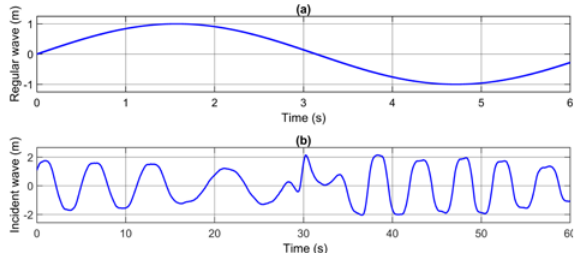
Fig. 7. Input wave data; (a) A regular wave for one wave period of 6 s in Case I; (b) The irregular waves for, Case II: 0-29 s, and Case III: 30-60 s.